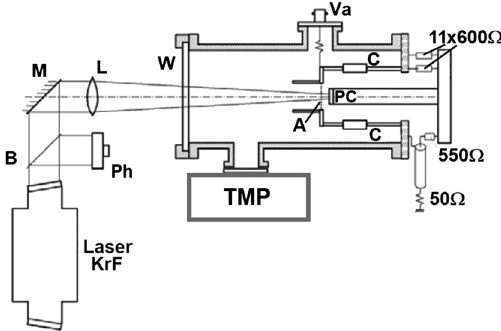
FIG. 1. Experimental apparatus: KrF, excimer laser; Ph , photo- diode; B , beam splitter; M , mirror; L , lens; W , quartz window; TMP , turbomolecular pump; C , capacitors; Va , anode voltage connector; A , anode; PC ,